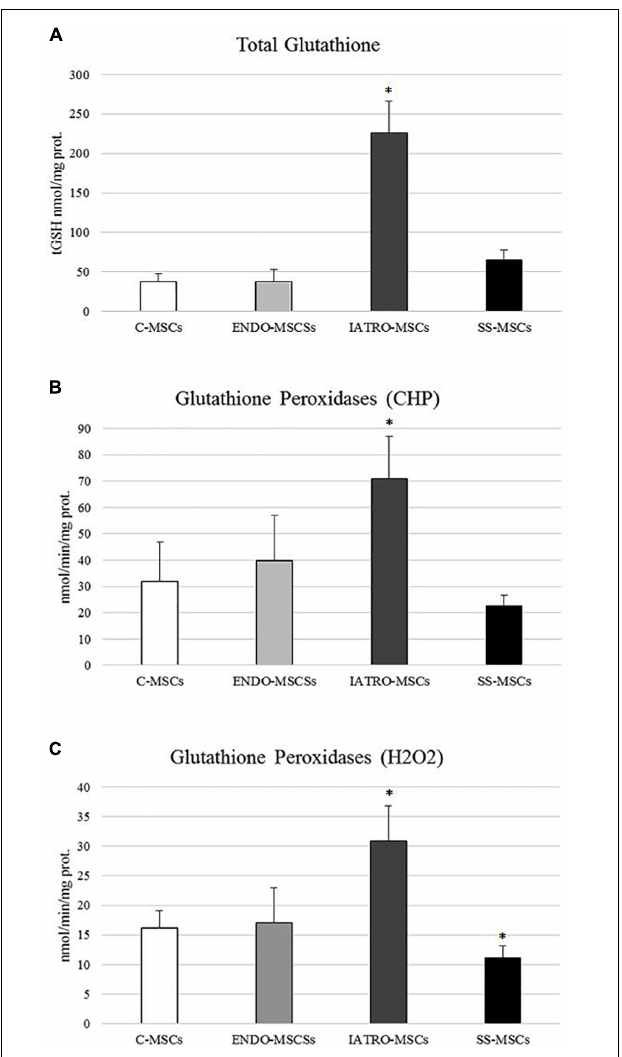
FIGURE 5 | (A) Amounts of total glutathione (GSH and GSSG in GSH equivalent) expressed as nmol/mg protein. (B) Glutathione Peroxidase activity was measured for both Se-dependent enzyme (H 2 O 2 ) and total GPX (CHP) activity. (C) Results are reported as mean values ± SD of three independent experiments. ∗ p < 0.05 MSCs from CS patients vs. C-MSCs. FIGURE 6 | (A) Glutathione-S-transferase (GST), (B) glutathione reductase